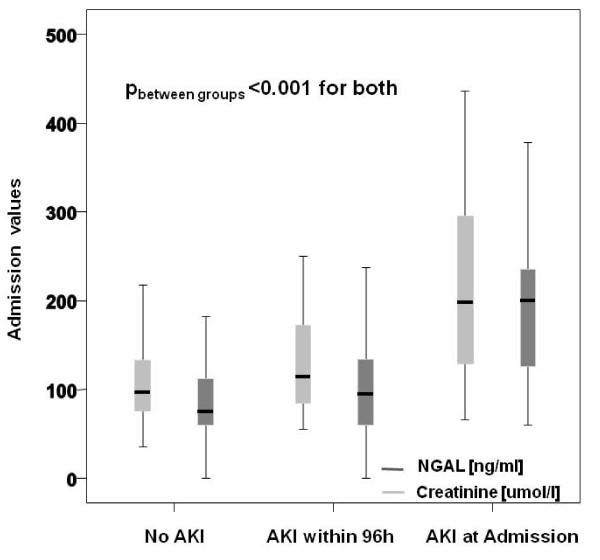
Box Plots showing plasma NGAL levels at presentation to the emergency department in AKI and non-AKI patients.